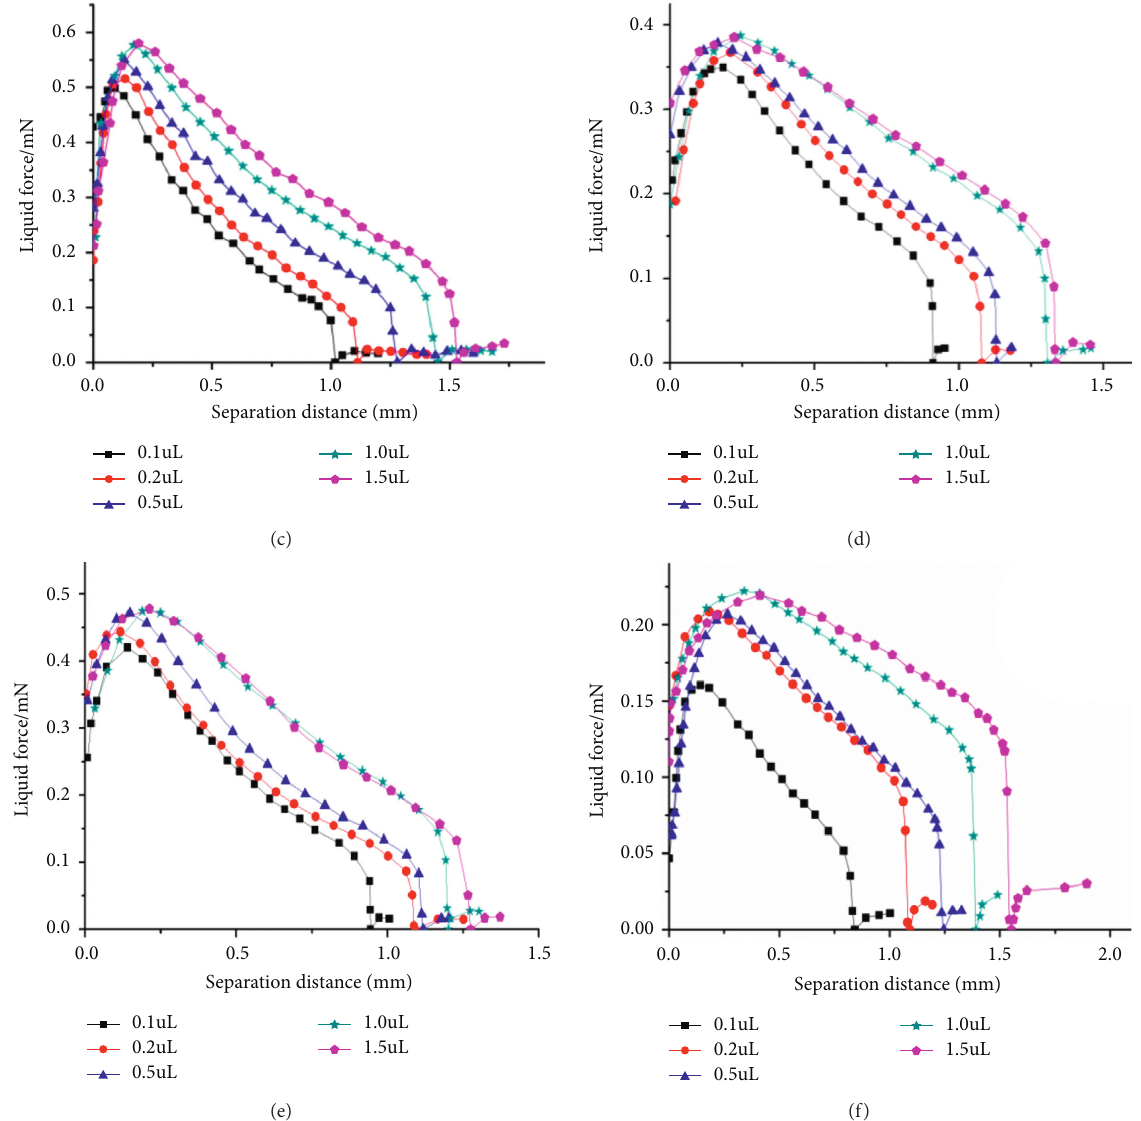
Figure 3: The liquid force-separation distance curve under different test conditions: (a) 2.5mm :2.5mm made by glycerol; (b) 4mm :4mm made by glycerol; (c) 5mm :5mm made by glycerol; (d) 2.5mm: 5mm made by glycerol; (e) 4mm :5mm made by glycerol; (f) 2.5mm: 5mm made by ethylene